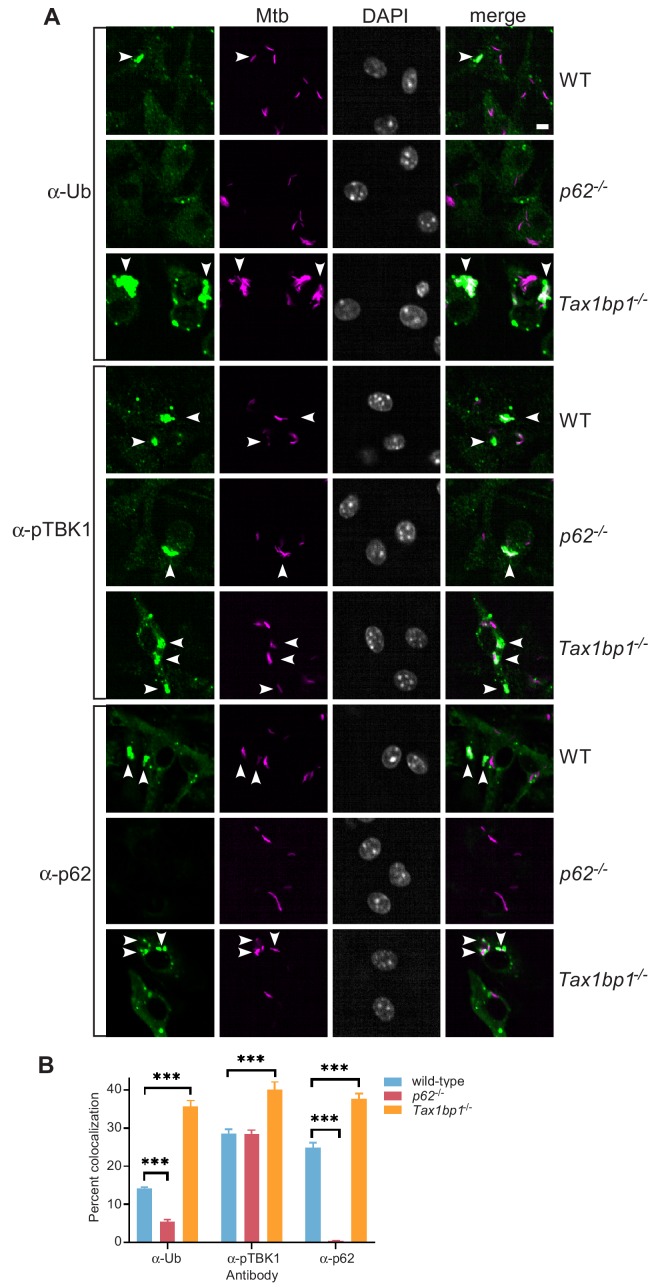
Accumulation of Mtb targeted to ubiquitin (FK2), p62, and phospho-TBK1 in TAX1BP1 targeted knockout macrophages.(A) Fluorescence images of wild-type, p62-/-, or Tax1bp1-/- bone marrow-derived macrophages infected with mCherry-expressing Mtb (magenta) and immunostained with antibodies to ubiquitin (FK2), p62, or phospho-TBK1 (green). Nuclei were stained with DAPI (white). White bar denotes 10 µm. (B) Quantitative analysis of Mtb colocalization with ubiquitin, p62, and phospho-TBK1 at 8 hr post-infection. Results are the means ± SEM from at least four technical replicates and a single experiment representative of three independent experiments. *** p value less than 0.001 by t-test.